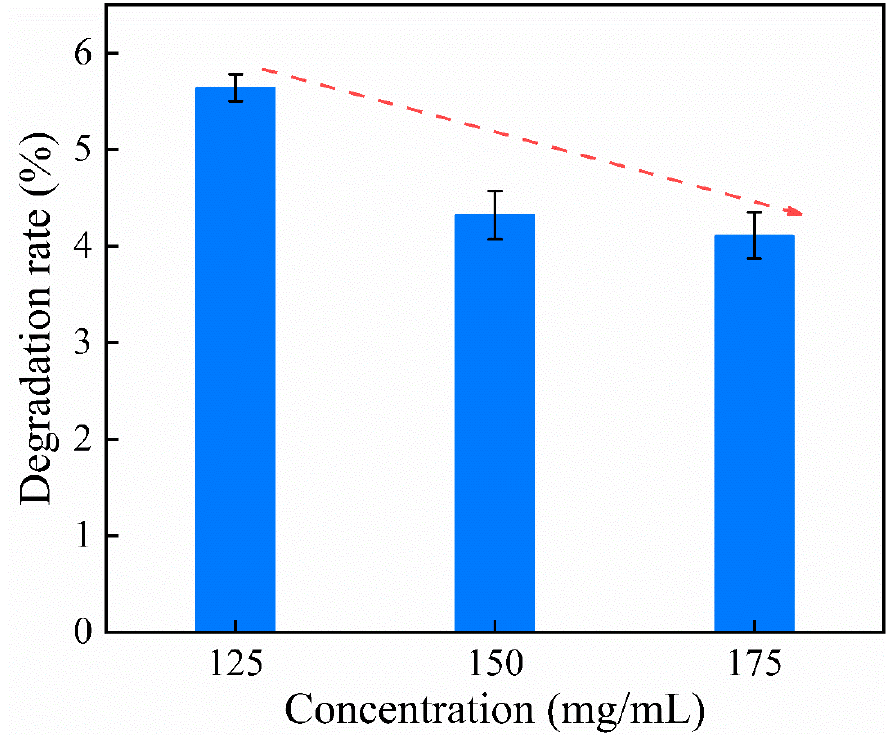
Figure 4. Effect of citral concentration on its degradation rate.